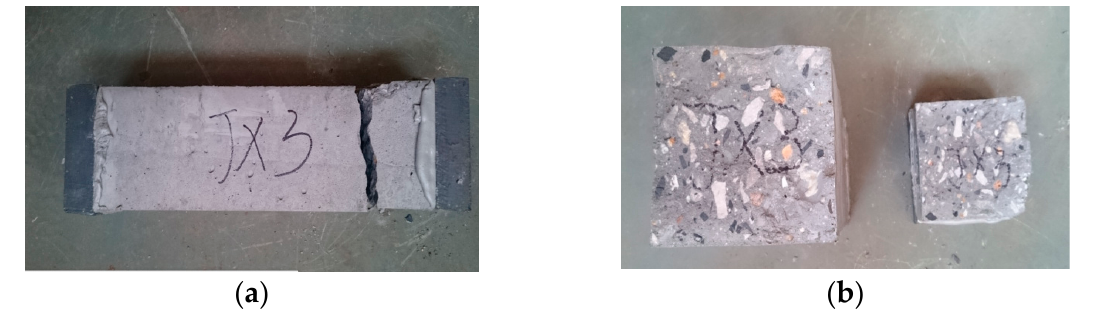
Figure 9. Failure modes of SCC prismatic specimens under cyclic direct tension. ( a ) Crack positions and ( b ) crack surfaces.